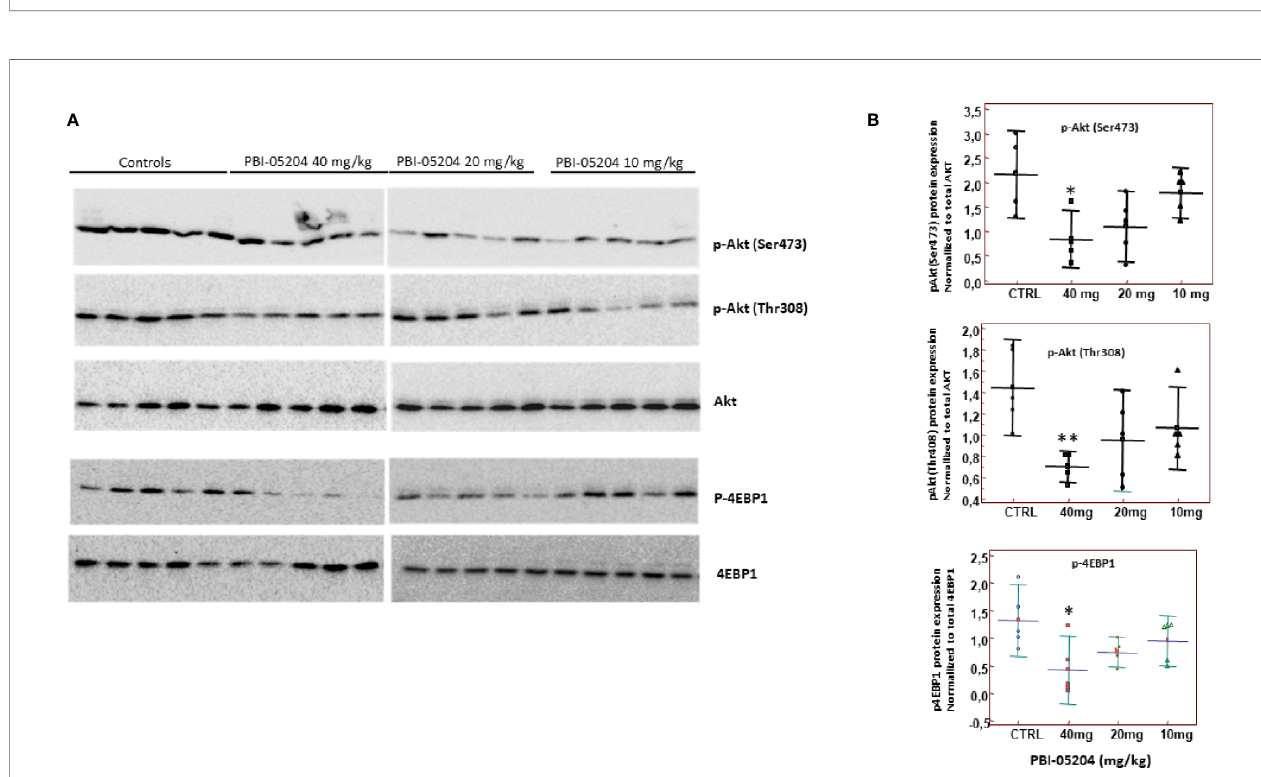
FIGURE 8 | PBI-05204 inhibited PI3k/mTOR pathway in U87MG tumor. (A) Western blot analyses of pAkt ser473, pAkt Thr308, total Akt, p-4EBP1, and total 4EBP1 in U87MG tumor tissues treated with PBI-05204. (B) Quantitative analysis of the aforementioned proteins (n = 5 per group). Data are presented as mean ± SD. *p < 0.05; **p < 0.01 versus tumor from control